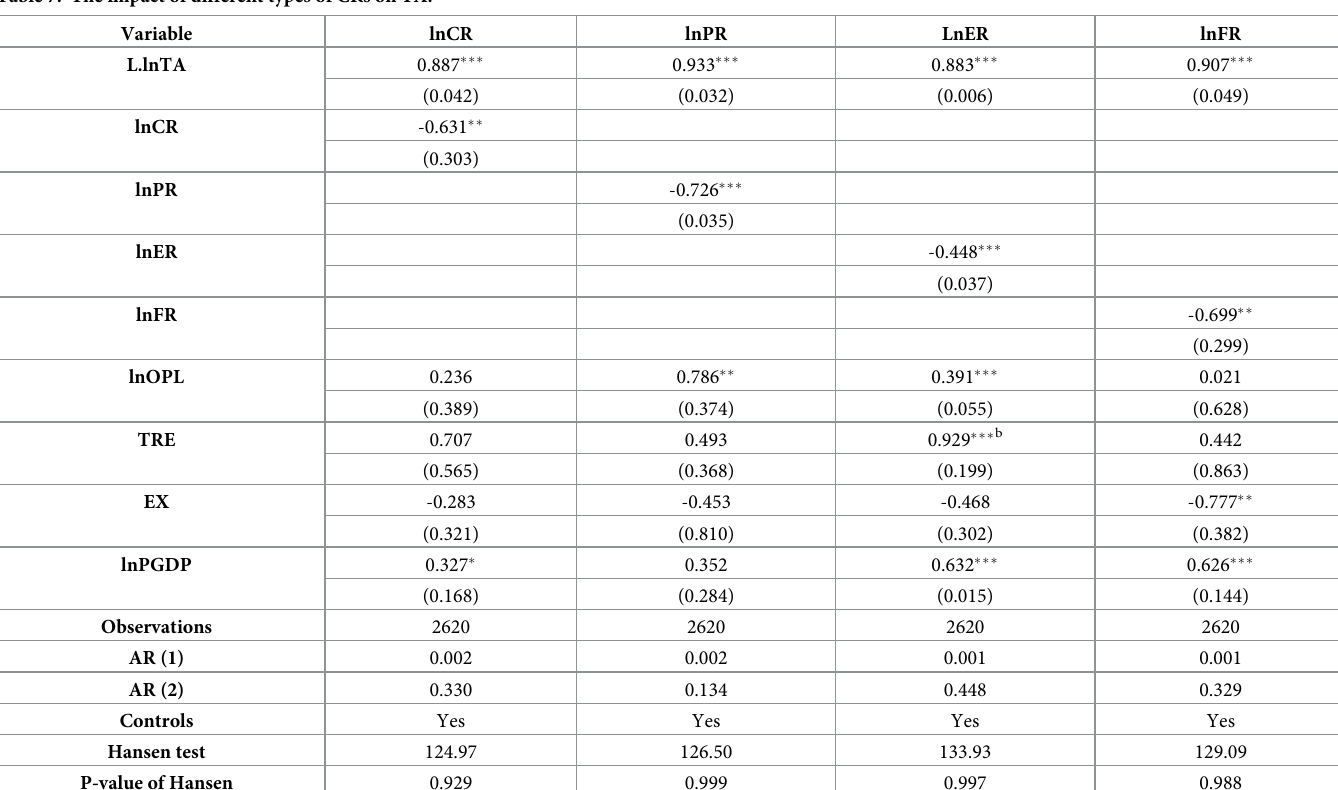
Table 7. The impact of different types of CRs on TA.